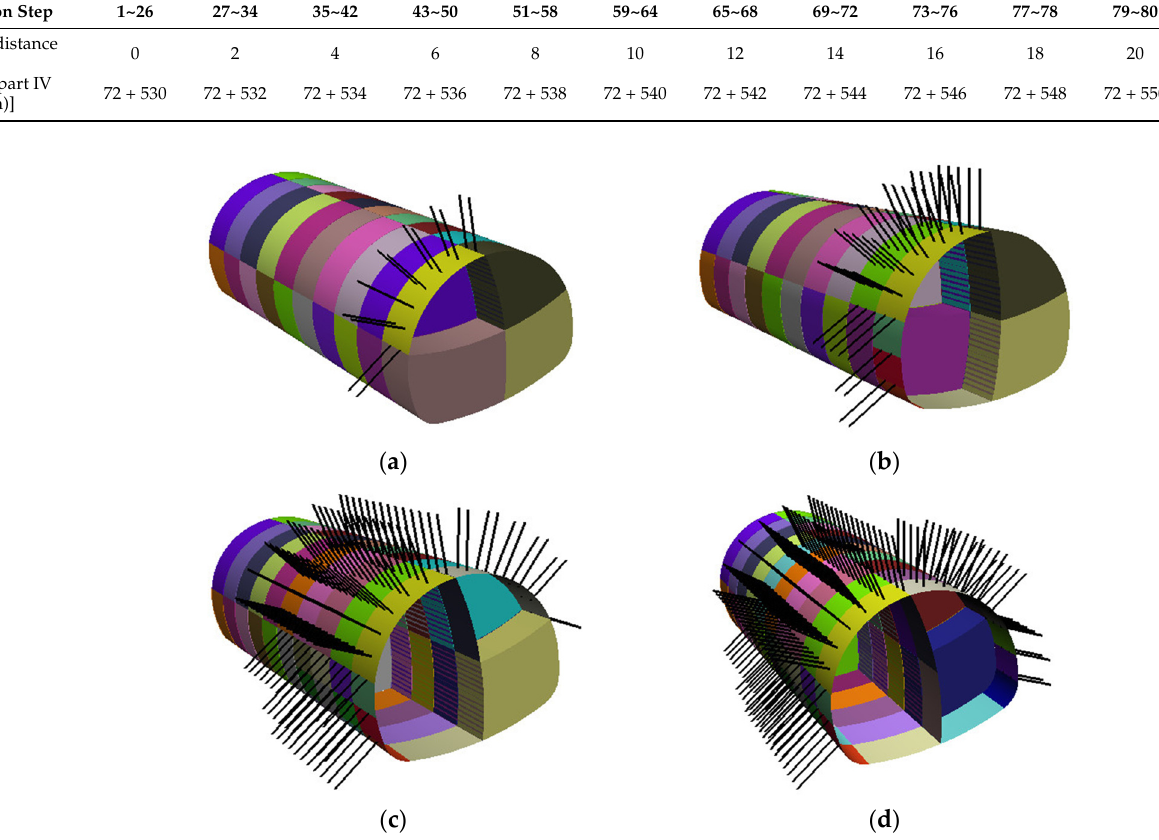
( c ) Figure 6. Numerical model. ( a ) meshed tunnel model; ( b ) supporting structures of new constructing tunnel; ( c ) supporting structures of existed tunnel.